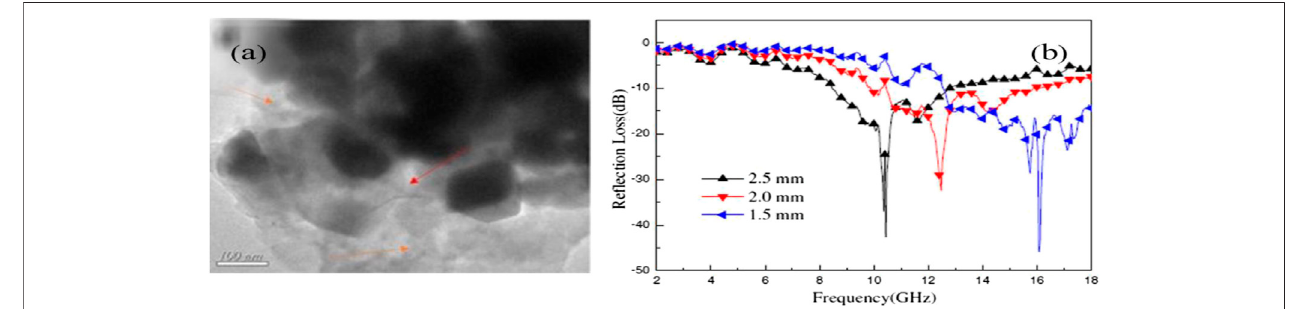
FIGURE 6 | (A) TEM image. (B) Re fl ection loss curve of rGO/SF/PANI composite (Luo et al.,